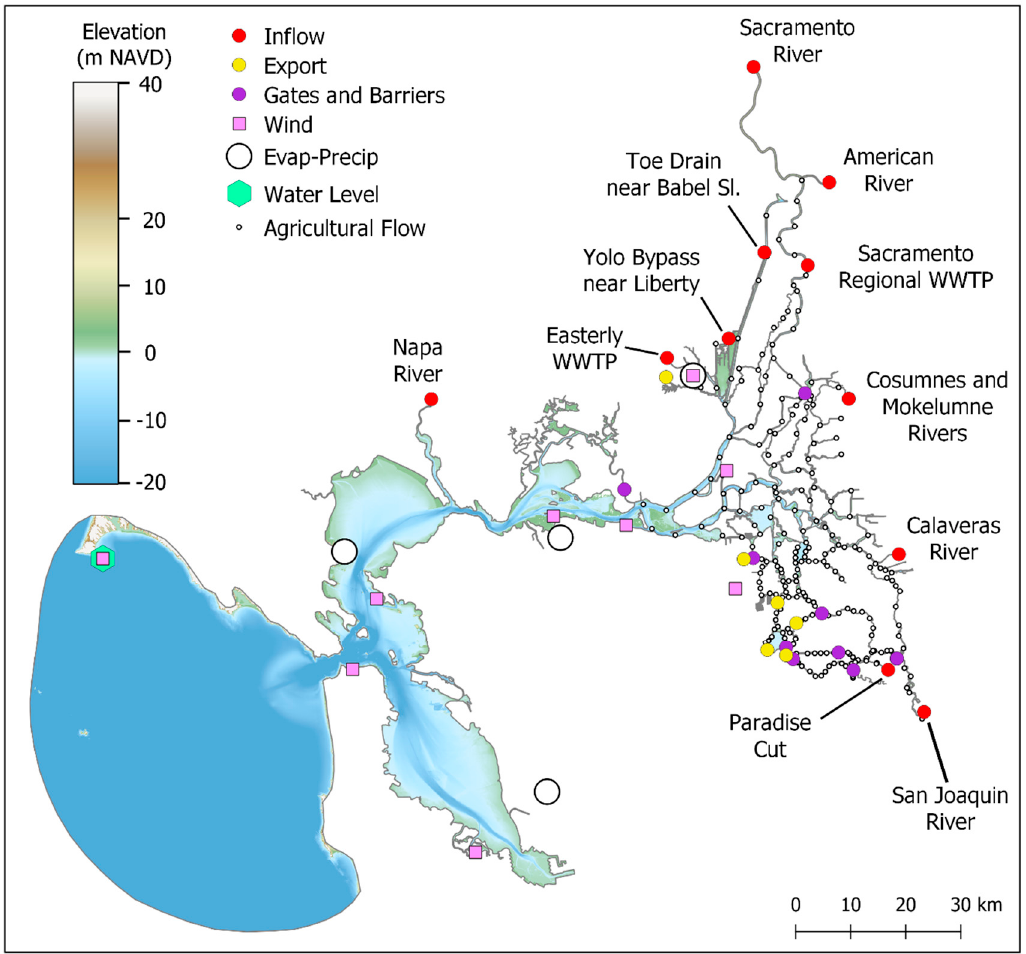
Figure 2. San Francisco Estuary model extent and bathymetry. Model boundary condition locations are shown for river inflows, diversions, agricultural flows, and hydraulic structures. Station locations used in setting regional wind and evaporation-precipitation model inputs are also shown.